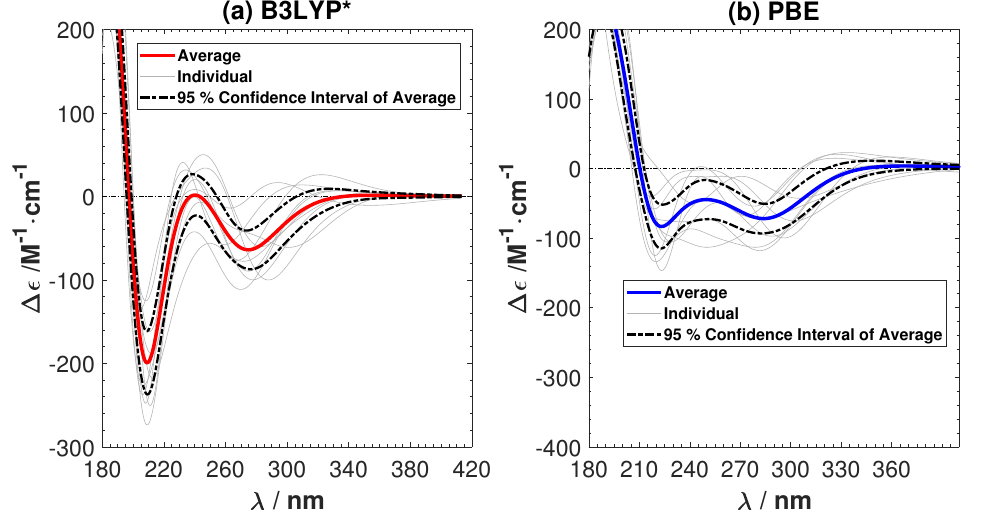
Figure 5. The average and individual ECD spectra of ten sampled structures with ( a ) the B3LYP* (15% Hartree–Fock (HF) exchange) and ( b ) the Perdew–Burke–Ernzerhof (PBE) functionals. No shiftings of the calculated spectra are